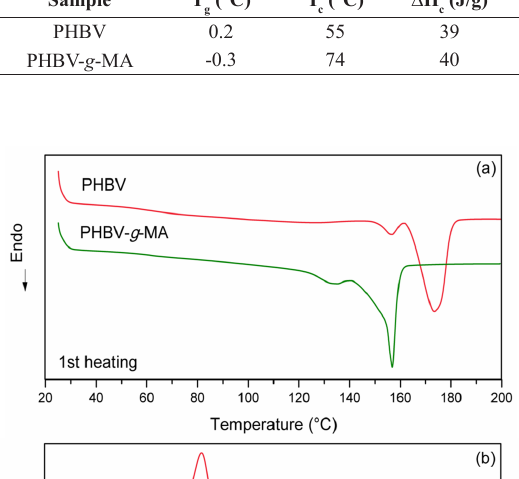
), melting enthalpy (∆H m